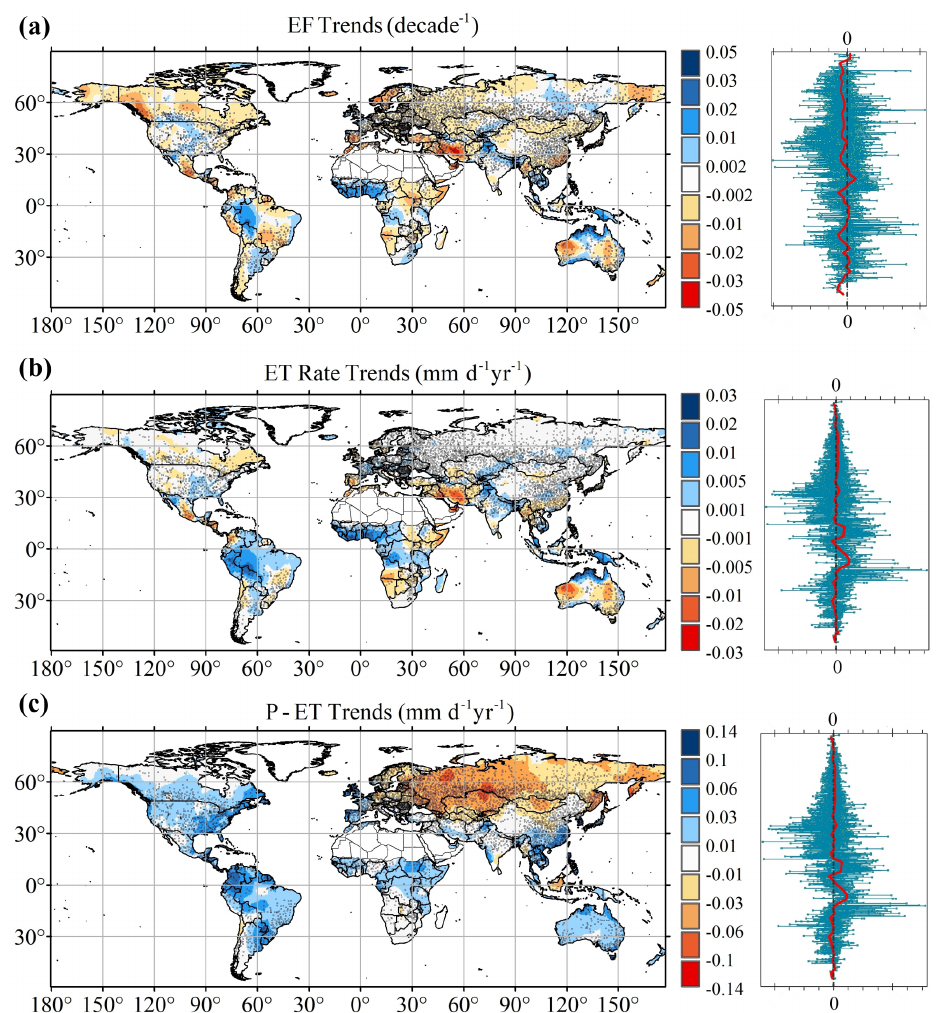
Figure 4. Long-term trends in evaporative fraction (EF), evapotranspiration (ET) and precipitation ( P ) minus ET ( P − ET). ET was converted from the ANN-retrieved latent heat flux. The red curve represents median trends at different